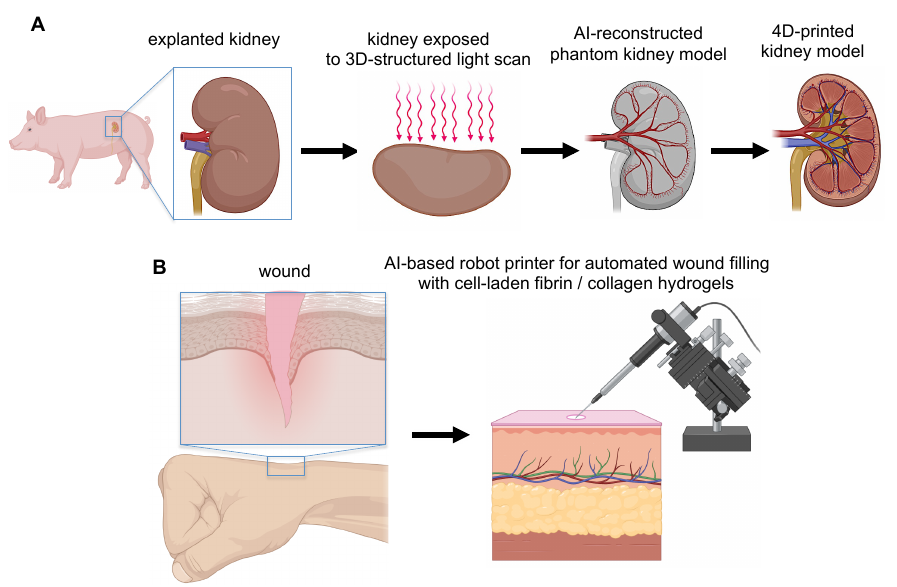
Figure 5. Schematic representation of open-loop AI-based 3D-printing approaches. (A) The open-loop structured light scan that allows the topographical matching of the geometry of the 3D-printed phantom biomimetic substrate with the anatomy of the porcine kidney, for fabricating microfluidic device conformably to this substrate and subsequently implantable to the surface of the porcine kidney. (B) Personalized skin 4D-printer to print cell-laden fibrin/collagen hydrogels on wounds in real time thanks to the coupling of computer-vision algorithms and structured-light scanner.